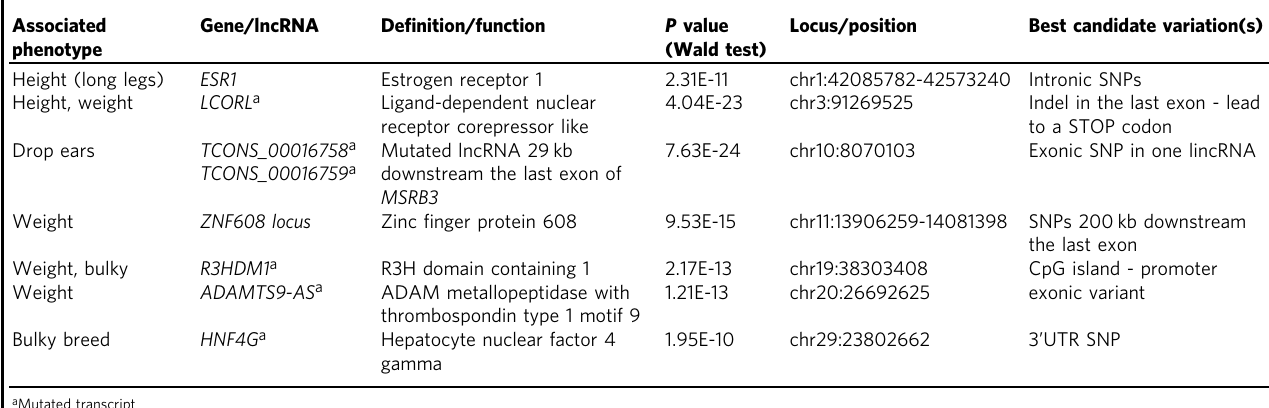
Table 3 Previously unreported candidate variants identi fi ed using the WGS canids catalog